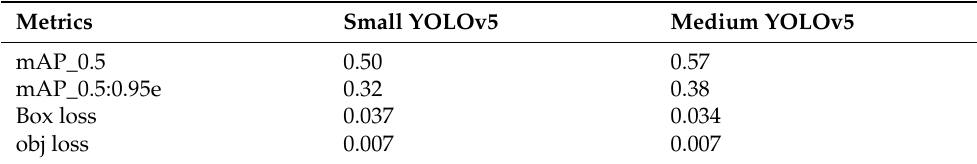
Table 9. Comparison of metrics between the small and medium versions of YOLOv5.